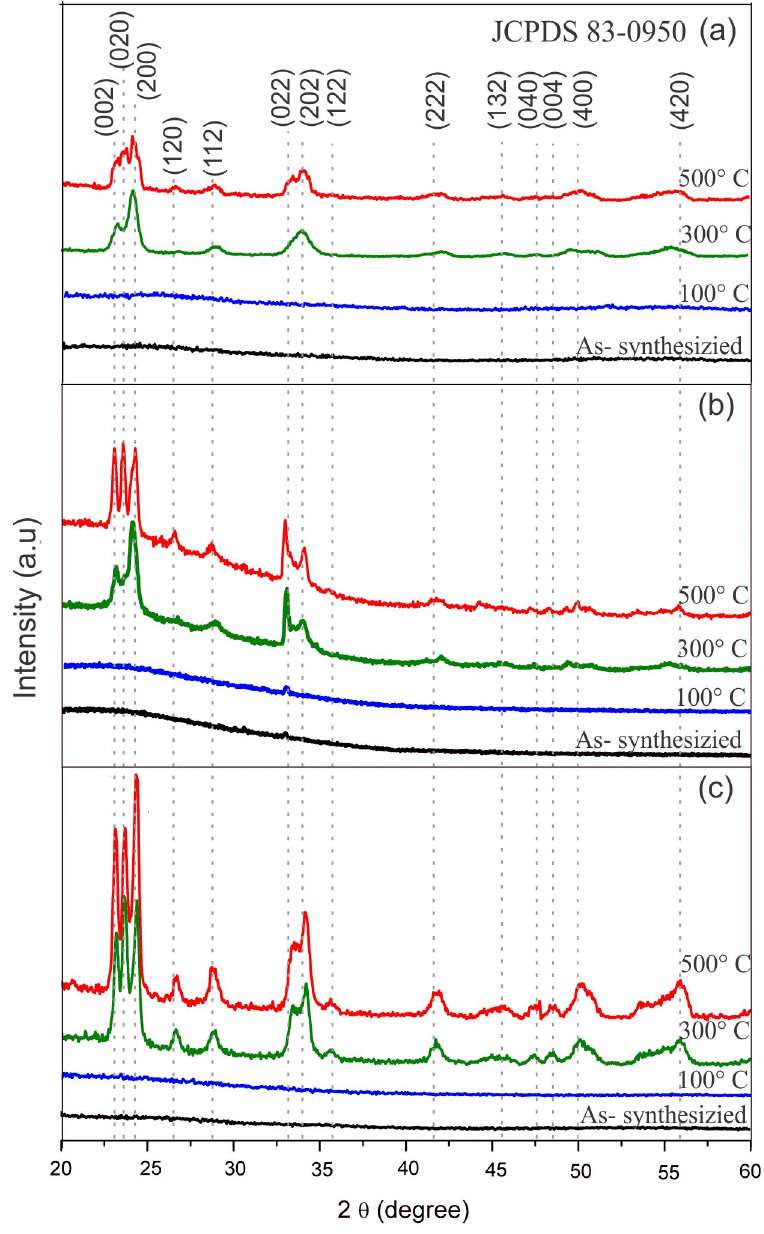
Figure 4. X-ray di ff raction (XRD) patterns for the di ff erent annealing temperatures of the samples: Figure 4. X-ray diffraction (XRD) patterns for the different annealing temperatures of the samples: ( a ) ( a ) s5m, ( b ) s10m, and ( c ) s5m, ( b ) s10m, and ( c ) s15m.